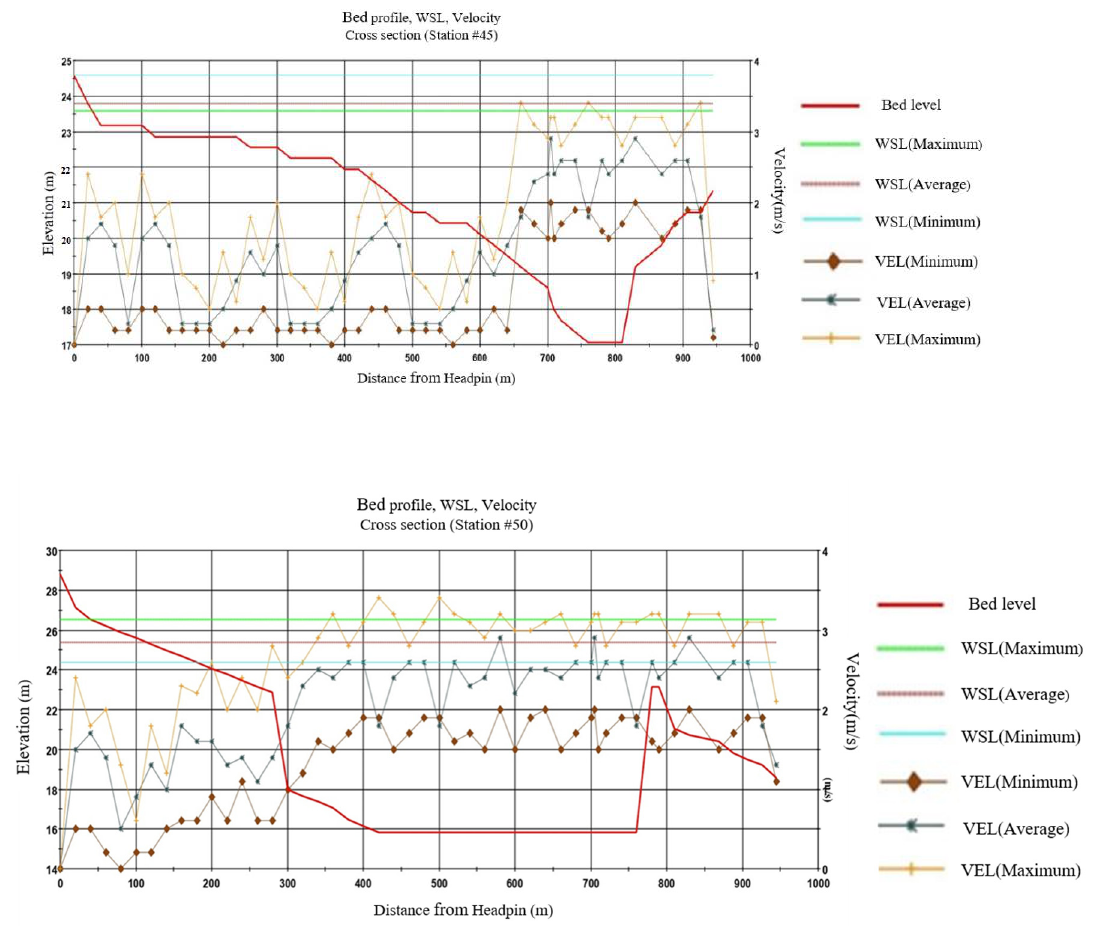
Figure 5. Velocity profile of sampling stations #45 and #50.